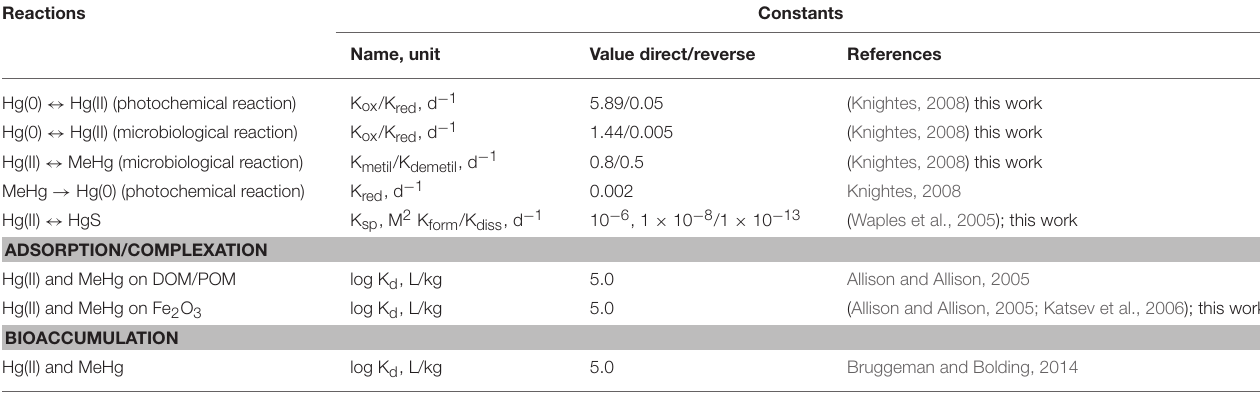
TABLE 1 | Parameters names, notations, values and units of the coefficients used in the model. Reactions